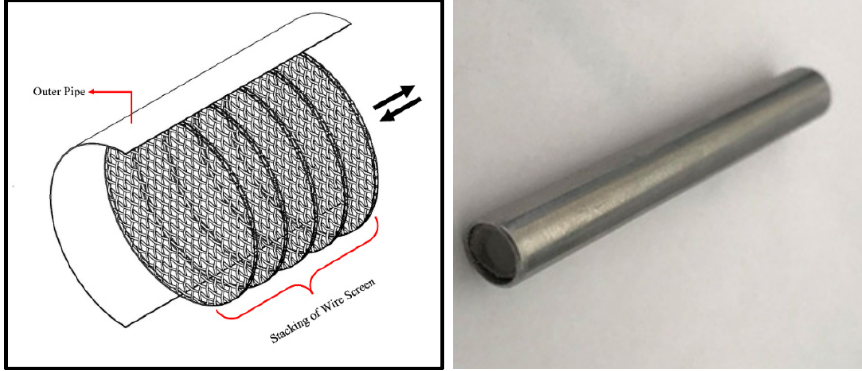
Figure 2. Stacking of a wire screen mesh inside the regenerator. Table 2. Regenerator parameters.